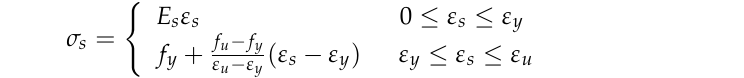
Table 4. Equations of bond strength between steel bar and UHPC.